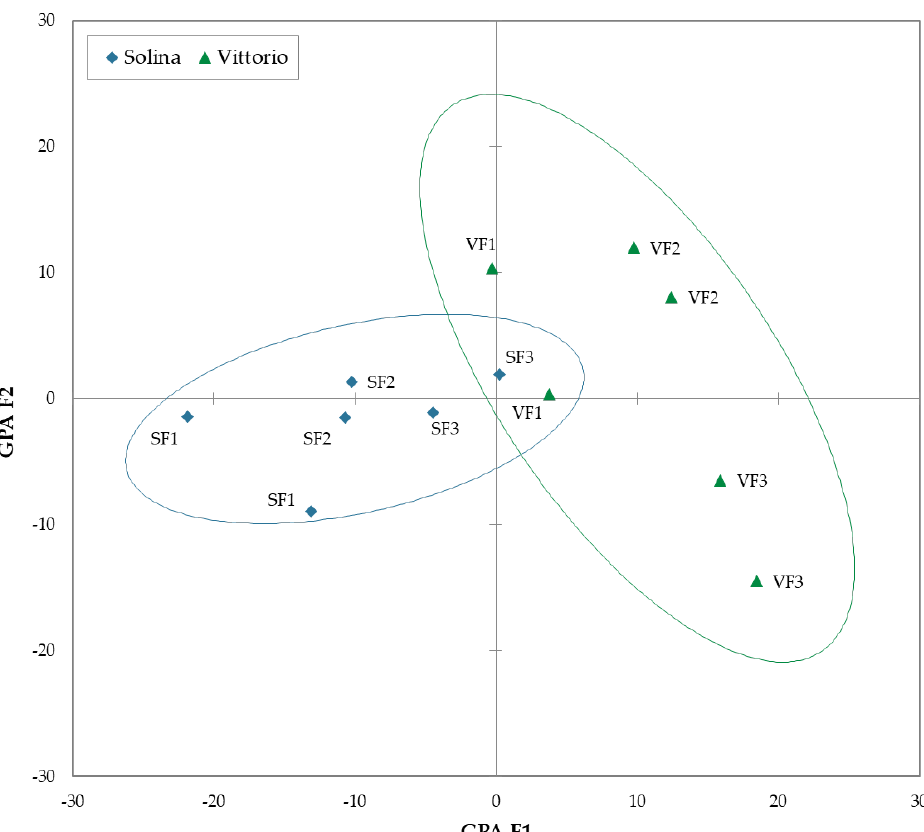
Figure 4. GPA plot of centroid coordinates by using GC-MS datasets, along the first and second factors. Score nomenclature: (V) Vittorio wheat; (S) Solina wheat; F1: 70 m a.s.l.; F2: 500 m a.s.l.; F3: 1200 m a.s.l. The ellipses indicate the 95% confidence limit.